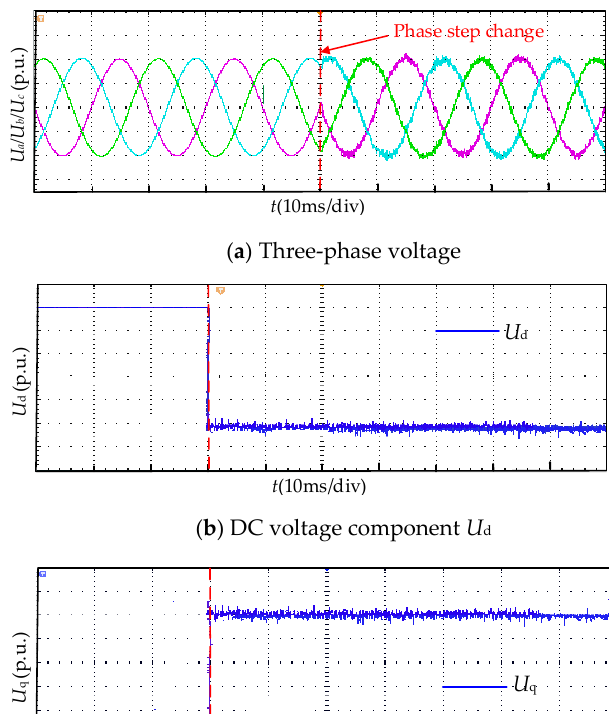
Figure 17. Experimental results.